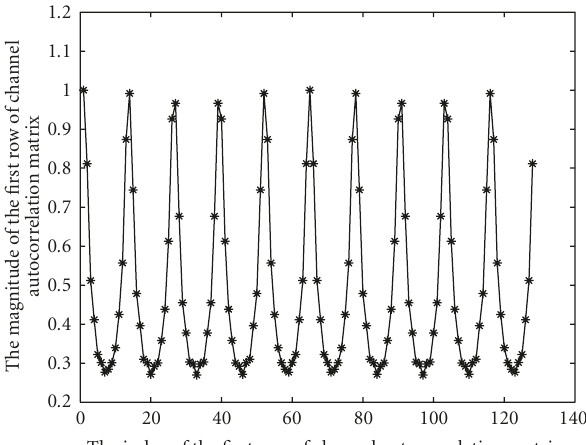
The index of the first row of channel autocorrelation matrix Figure 3: The first row of the channel autocorrelation matrix , A R H p H p